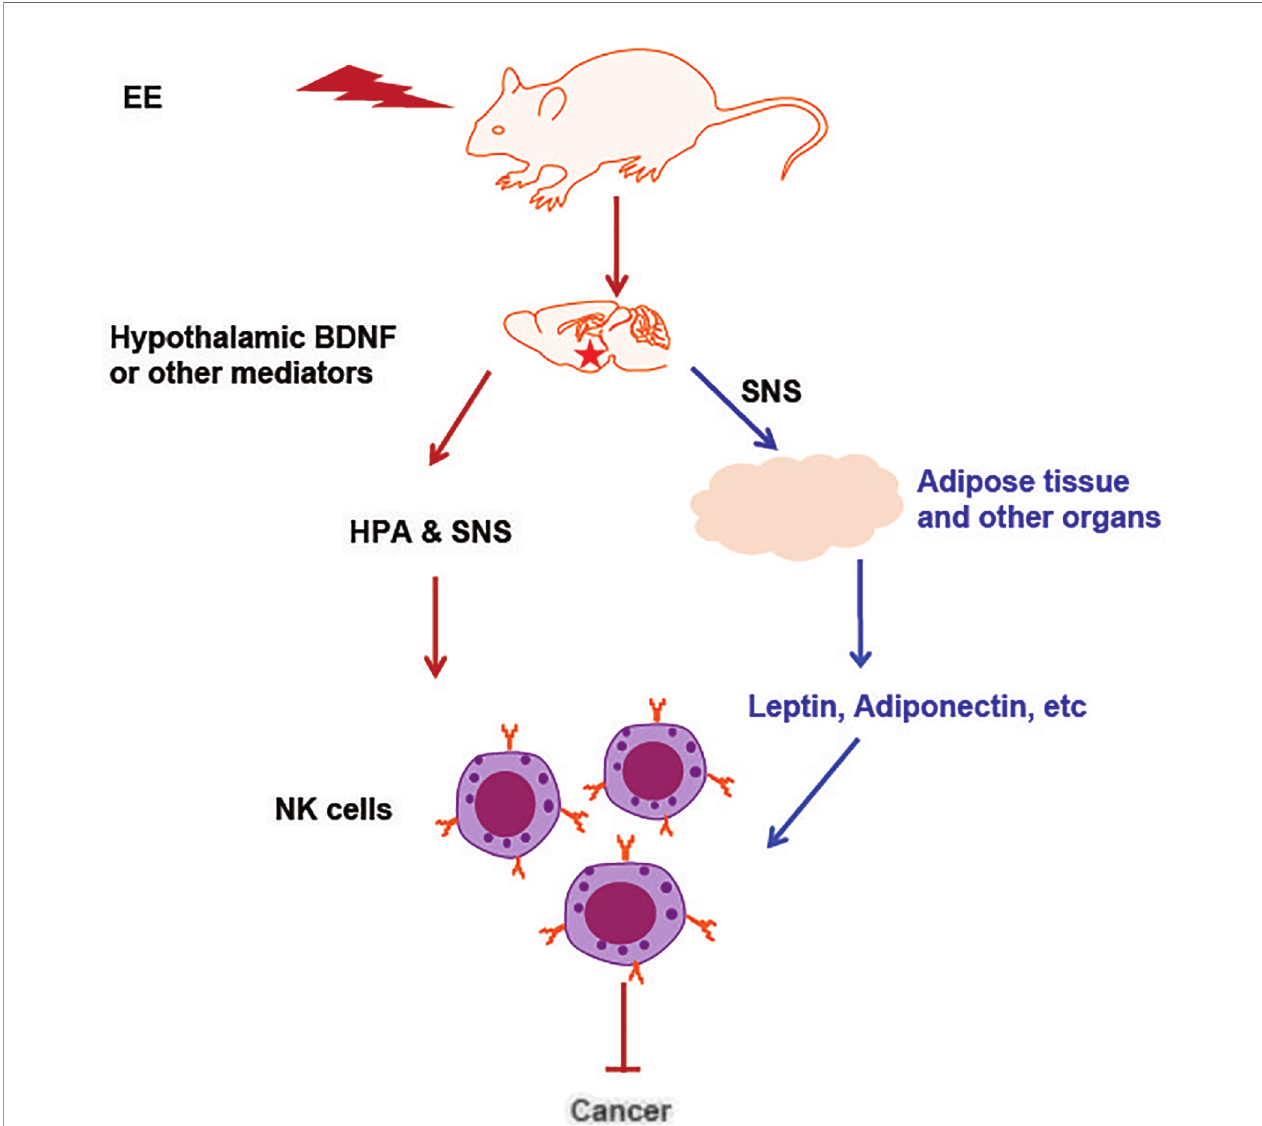
FIGURE 2 | An illustration of NKcell activation andcancer inhibition induced byEE. The induction ofhypothalamic BDNF orother brain mediatormolecules in response to environmental stimuli leads to the activation of the SNS and HPA axes, which can directly act on NK cells. Another pathway isthatEE impactedorganswith endocrine function secrete adipokines, cytokines orhormones andsubsequently act onNKcellsthat residinginthe organ.The adipokines orcytokines also enter circulation,reach the distant organsand regulateNK cells there. Allthese effects contribute to EE inducedimmune protection against cancer and other